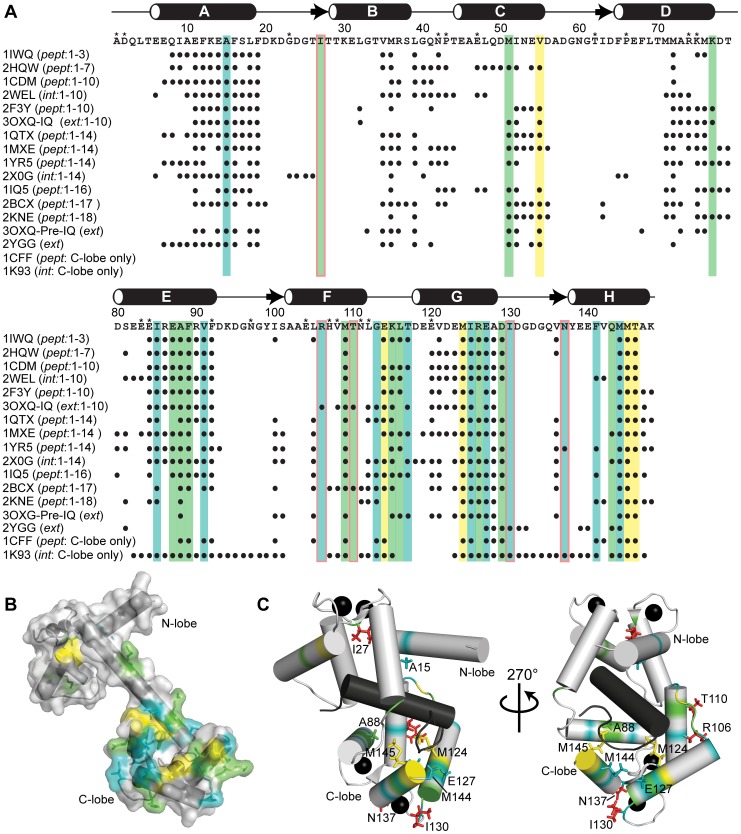
Comparison of the Ca2+-CaM:Apo-Lf Interface with Other Known Ca2+-CaM:Target Interfaces.
A) Summary of the CSP and saturation transfer data depicted on the primary sequence of CaM. Residues perturbed upon binding of apo-Lf are highlighted in green, cross-saturated are shown in blue, those that experience both CSP and cross-saturation in yellow, and missing residues by an *. Black circles indicate CaM residues for which amide atoms are found within 6.5 Å from the target peptide or protein in the indicated CaM complex deposited in the PDB. A red box highlights residues involved in the interaction with apo-Lf but uncommonly involved in interaction with other targets. The structures as indicated by their PDB codes are as follows: 1IWQ: MARCKs, 2HQW: NMDA receptor, 1CDM: CaMKIIα, 2WEL: CaMKIIδ, 2F3Y: CaV1.2 Ca2+ channel IQ domain motif, 3OXQ: CaV1.2 Ca2+ channel pre-IQ/IQ domain, 1QTX: smMLCK, 1MXE: CaMKI, 1YR5 and 2X0G: DAPK, 1IQ5: CaMKK, 2BCX: ryanodine receptor, 2KNE: plasma membrane Ca2+ pump, 2YGG: Na+/H+ exchanger NHE1, 1CFF: plasma membrane Ca2+ pump, 1K93: B. anthracis oedema factor. For each, whether or not the CBD is represented by a peptide (pept), extended sequence (ext), or the intact protein (int) is indicated. The classification of the CaM-binding motif is also shown. The secondary structure of Ca2+-CaM is indicated above: cylinders and arrows indicate α-helix and β-strand, respectively. CaM amino acid residues experiencing a significant change in chemical shift or cross-saturation upon binding apo-Lf are mapped on the structure of B) free Ca2+-CaM (PDB code 1CLL) or C) Ca2+-CaM bound to the CBD of CaMKK (PDB code: 1IQ5). In both, the same coloring scheme as in A is employed. Highlighted side chains reflect amino acid residues commonly found at the interaction interface, except those colored in red which reflect residues rarely involved in the binding interface.